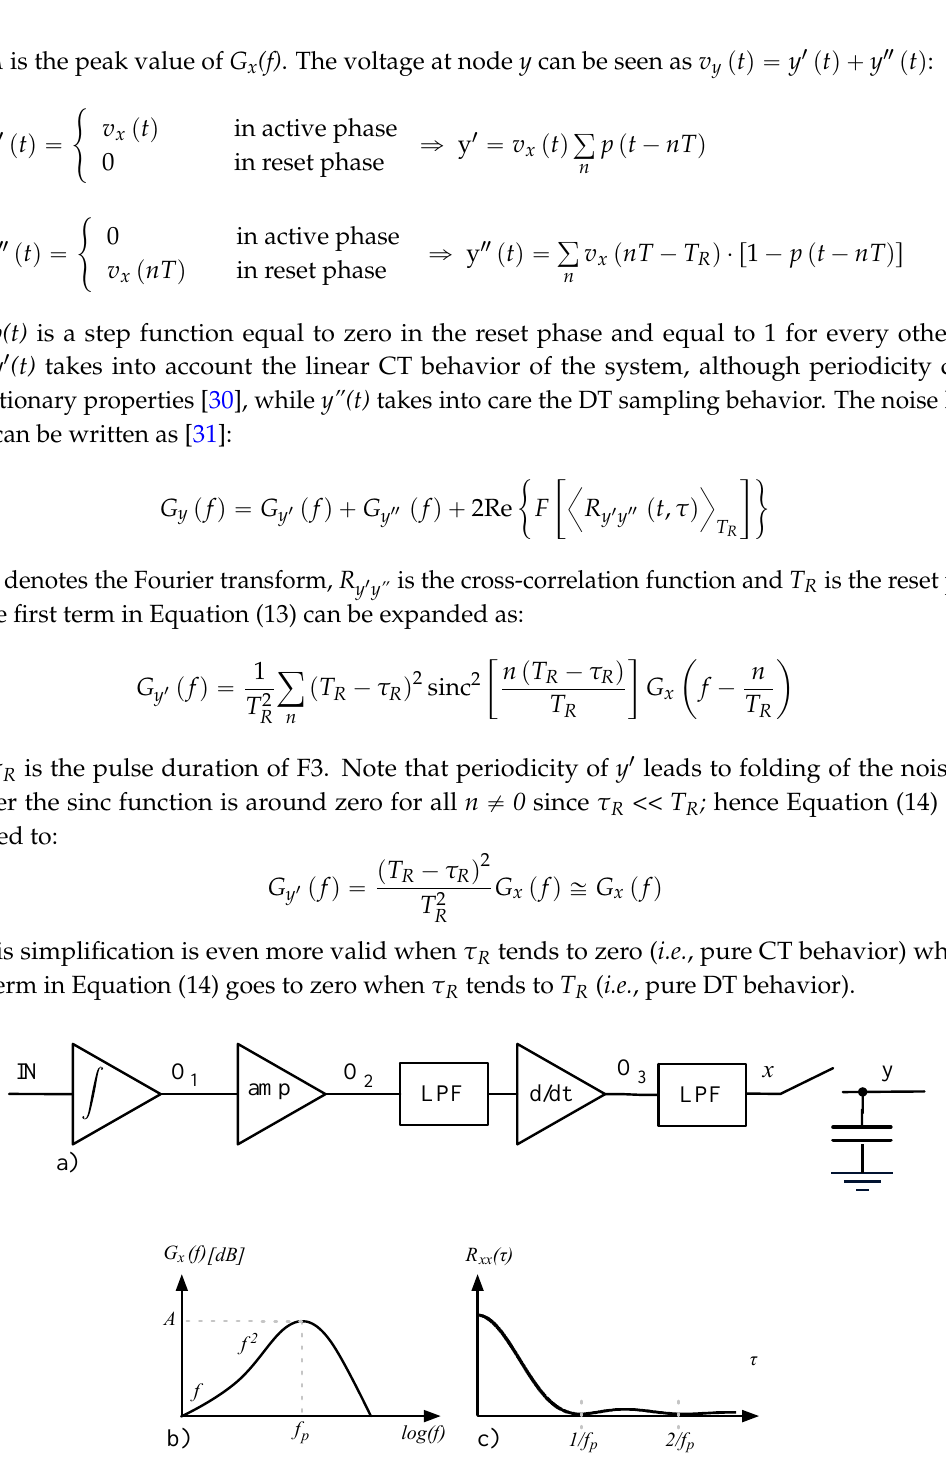
Figure 9. ( a ) Simplified block scheme of the proposed architecture. Noise analysis is based on this system simplification where sampling is decoupled from the Sallen-Key filter; ( b ) Qualitative sketch of the noise PSD at node x ; ( c ) Qualitative sketch of noise autocorrelation function at node x .